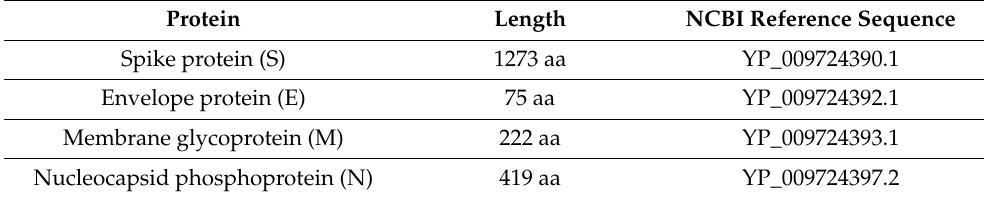
Table 2. Sequences of the structural proteins of SARS-CoV-2 used for the analysis. Protein